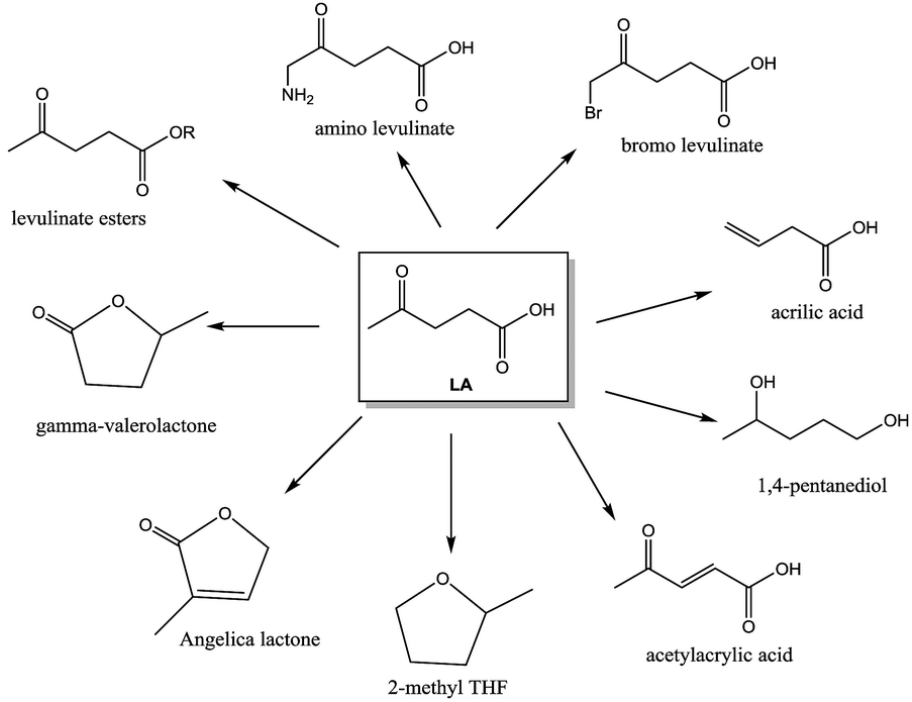
Figure 8. Exemplification of LA-derived chemicals (reprinted with permission from [91]. Copyright © 2018, Royal Society of